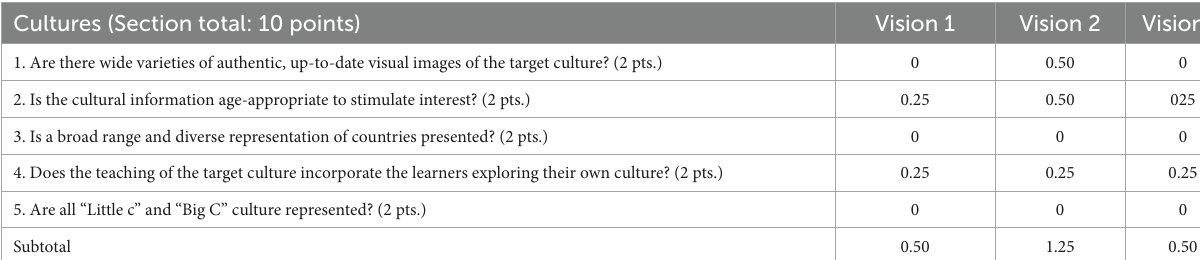
TABLE 5 Evaluation of Vision Series textbooks based on cultures. Cultures (Section total: 10 points)